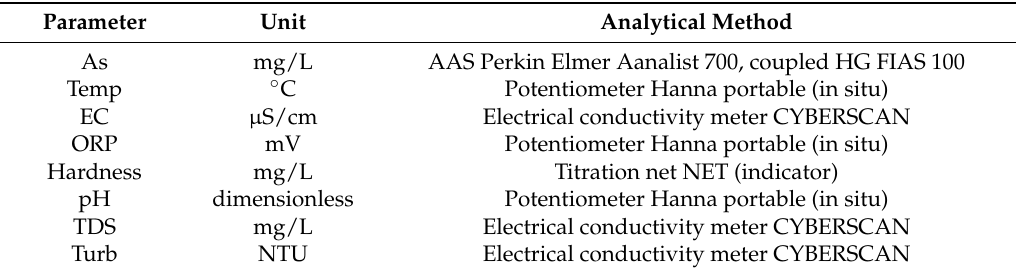
Table 1. Physicochemical parameters in water, units, and analytical